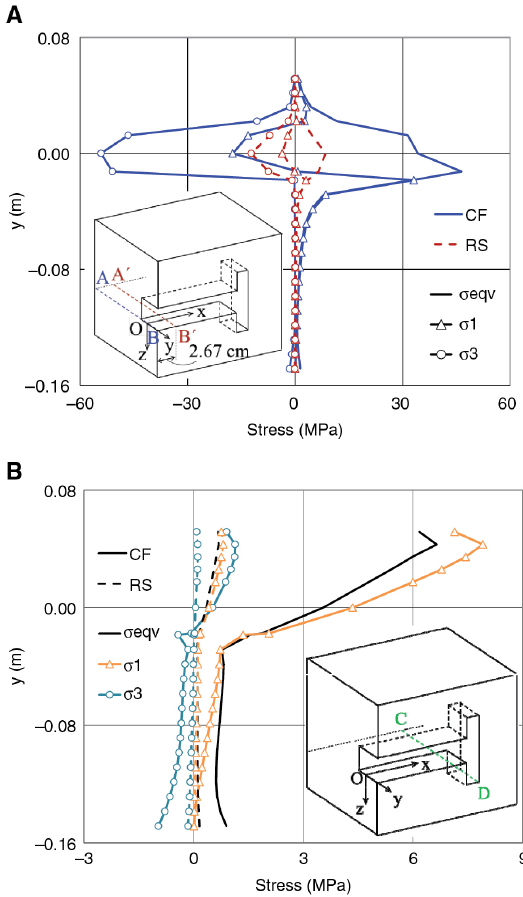
Figure 11: The variation of the maximum tensile, the maximum compressive and the von Mises equivalent stress along (A) the AB and A ΄ B ΄ lines, and (B) the CD